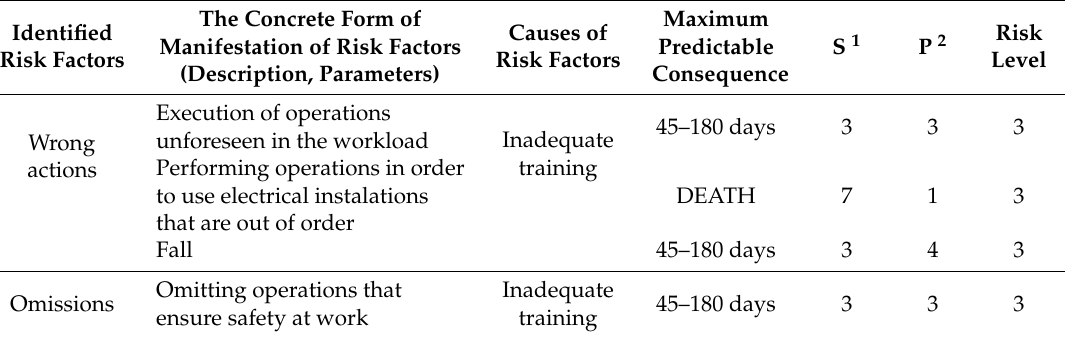
Table 4. Analysis and evaluation of the risks of injury and occupational disease related to factors of performer.